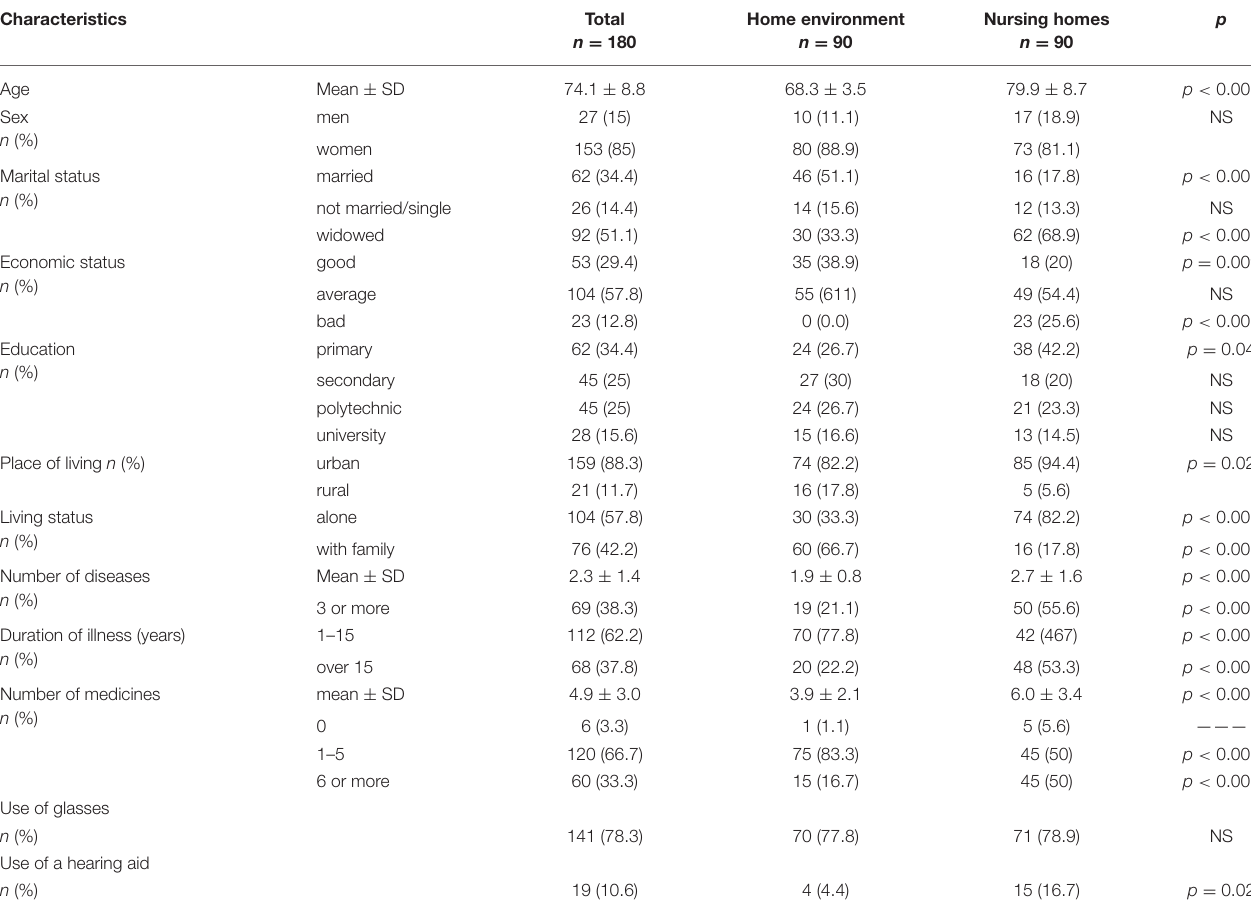
TABLE 1 | Sociodemographic and clinical characteristics of the study group ( n = 180).